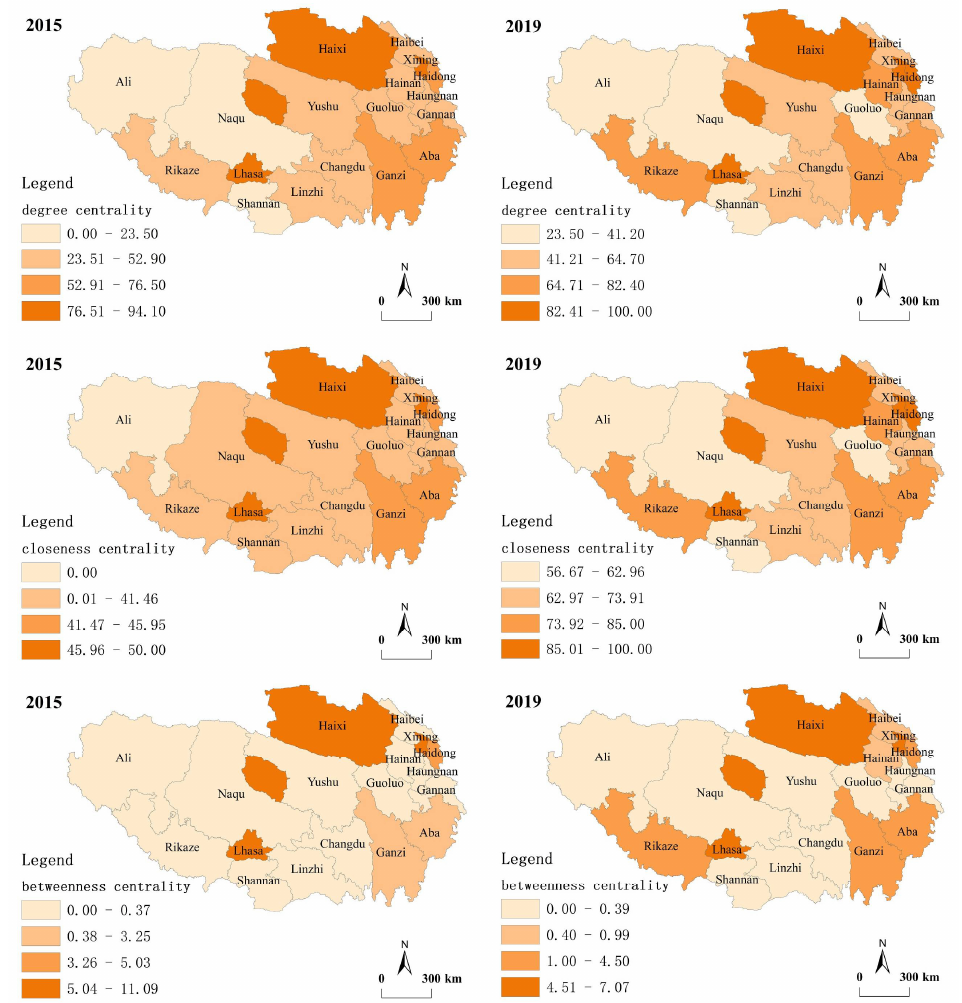
Figure 5. The spatial distribution of the degree, betweenness, and closeness.